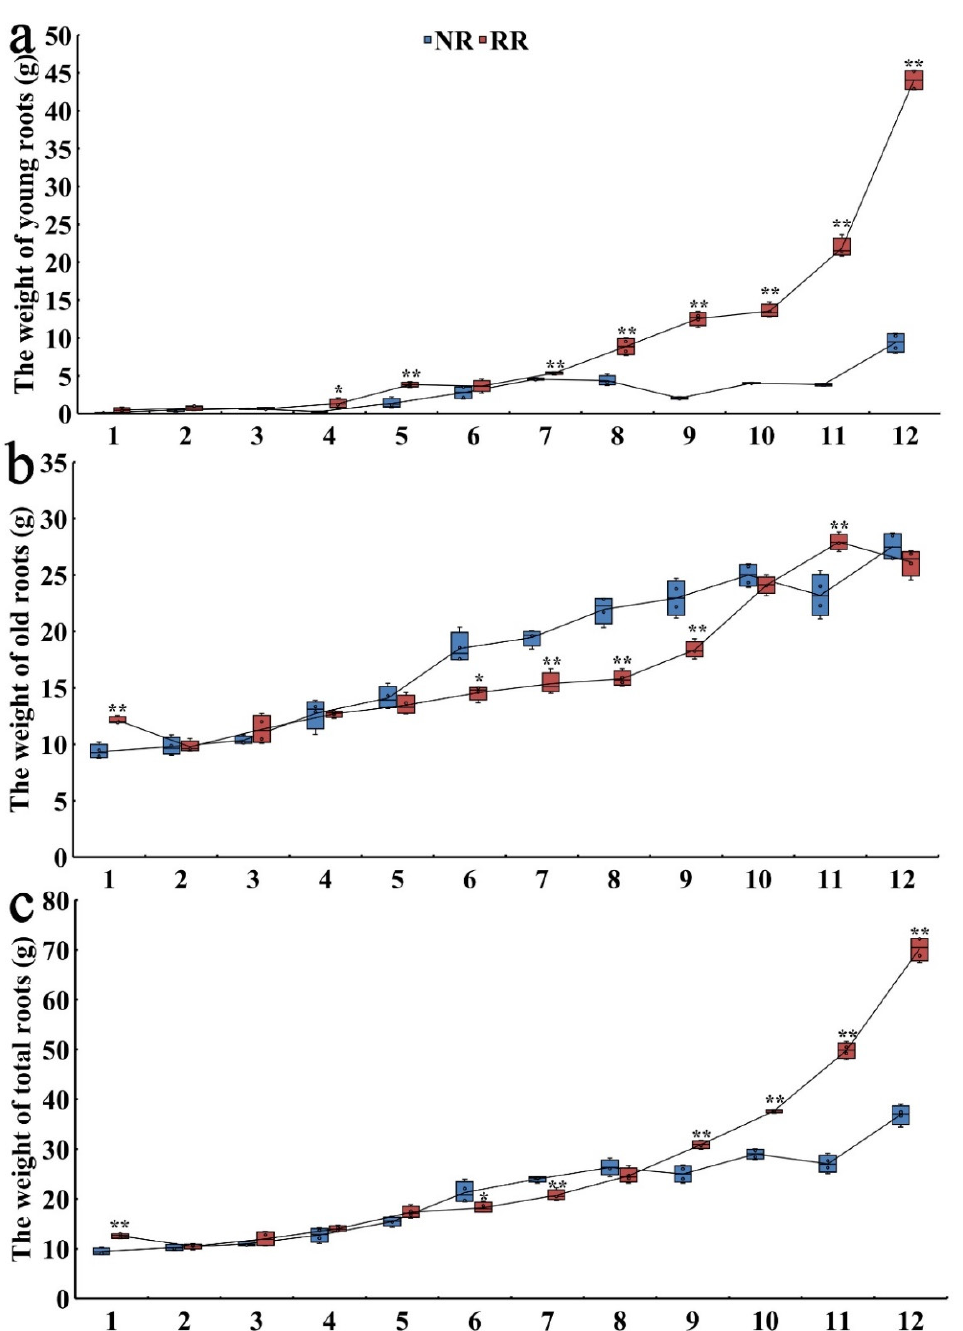
Figure 2. Root weight variations of one-year-old self-rooted grapevine cv. “Muscat Hamburg” on the condition of NR and RR. The weight of young roots ( a ), old roots ( b ), and total roots ( c ) was counted in NR and RR cultivation. 1–12 indicate the sample collection time points. Error bars show the standard error between four biological replicates. Values are statistically significant from the control cultivation based on t -test (* p < 0.05 and ** p <